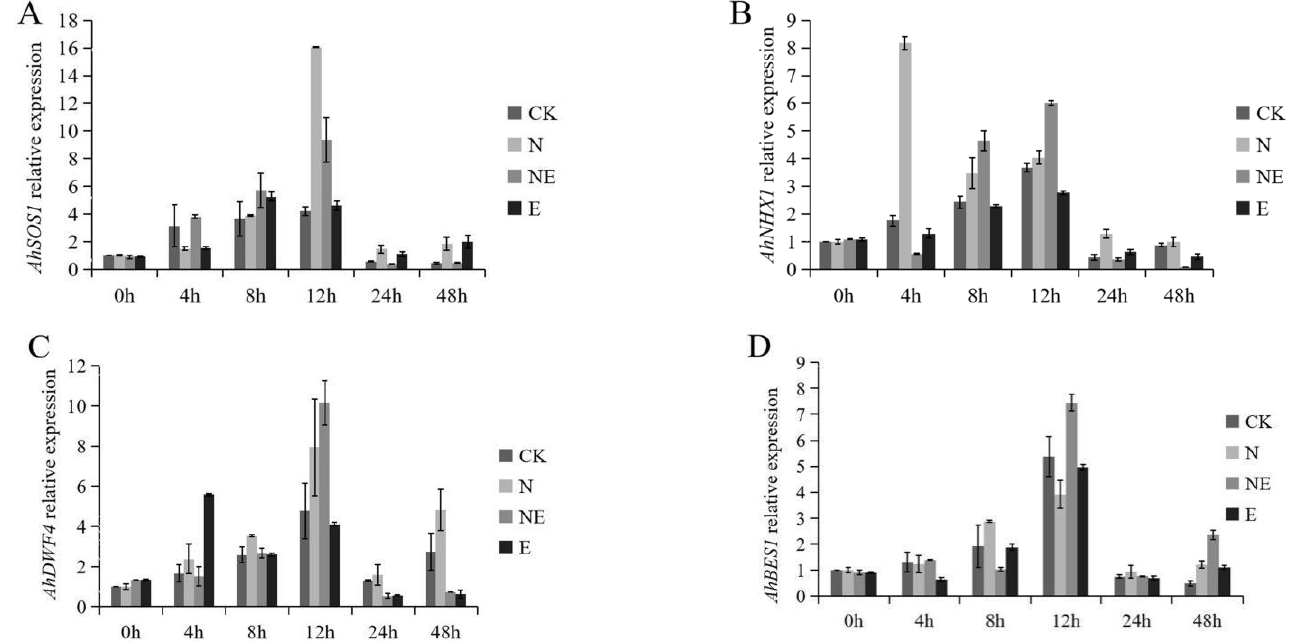
Figure 7. Effects of EBL treatments on key genes relative expression of peanut seedling under salt stress. CK (normal conditions), N (treated with 150 mM NaCl), NE (treated with 150 mM NaCl and 0.1 µ M EBL) and E (treated with 0.1 µ M EBL). ( A ) AhSOS1 relative expression; ( B ) AhNHX1 relative expression; ( C ) AhDWF4 relative expression; ( D ) AhBES1 relative expression.